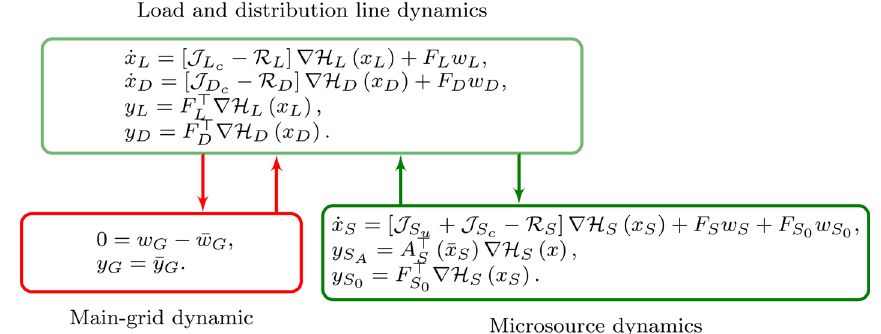
Fig. 5 Microgrid Overall Dynamic: port-Hamiltonian